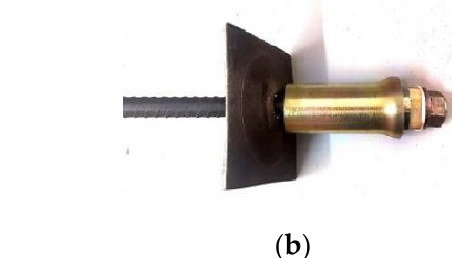
Figure 1. Energy absorbing anchor structure diagram. The right outer surface of the energy absorbing anchor rod is provided with an external thread, the nut is screwed to the right end of the rod through the external thread, and the anchorage force warning stopper is fixed on the axial right end of the nut. The pre-tightening force warning washer, the energy-absorbing casing bulging block, the constant resistance energy absorber [21], and the tray are set on the rod body in order, as shown in Figure 2. The constant resistance energy absorber is a thin-walled round tube structure, the right end of the constant resistance energy absorber has a flared mouth structure, the constant resistance energy absorber is coated with reflective paint, and the bearing capacity of the constant resistance energy absorber is designed to be 95–100% of the yield force of the rod. The left side of the energy-absorbing casing bulging block is a conical structure, the right side is a cylindrical structure, the right end is a flat structure, and the center is to the left of the rod penetration hole. The conical structure of the energy-absorbing casing bulging block is in contact with the flared structure of the constant resistance energy absorber.